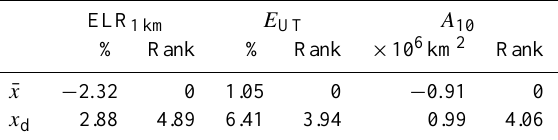
Table 3. Differences between EMAC and MATCH-MPIC annual values and corresponding ranks for ELR 1km , E UT , and A 10 for the 36 MPCs. ¯ x , mean difference; x d , corresponding mean absolute de- where x i is the metric value of an MPC and N is the total number of